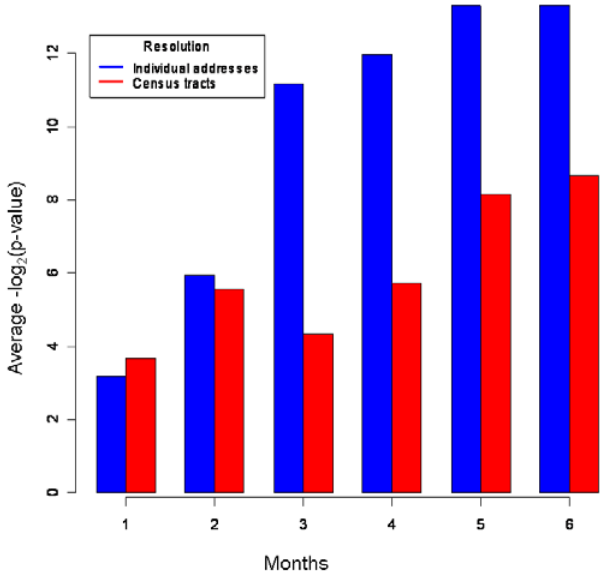
Figure 5. Average detection timeliness of the method applied to simulated outbreaks using a fixed spatial window of 0.2 km with increasing time window. The average -log 2 transformed p-value was calculated across the same 12 geographic regions as those used in Figure 4 for individual addresses (blue bars) versus census tract centroids (red bars) with increasing counts of simulated cases, one for each month.